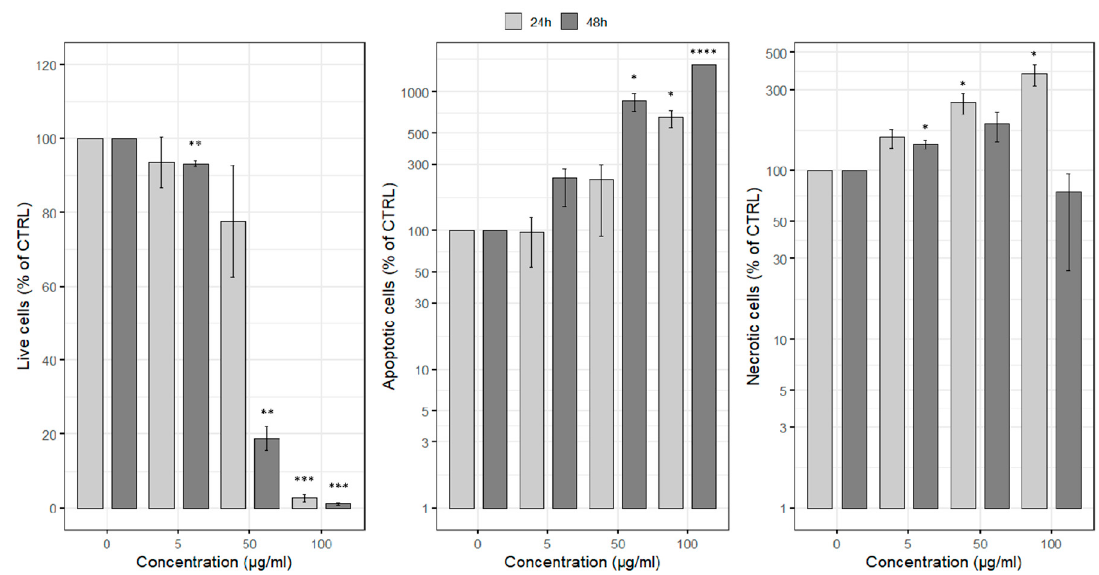
Figure 4. Flavone induces apoptosis in SNU-1 cells. Cells (2.5 × 10 5 ) were treated with increasing concentrations of flavone for 24 h and 48 h, and the amount of apoptotic cells was determined by flow cytometry. The apoptosis rate was estimated in comparison to the untreated cell. Data were presented as mean and standard error of three individual experiments and were analyzed with a one-sample t -test. * p < 0.05, ** p < 0.001, *** p < 0.0001 and **** p <